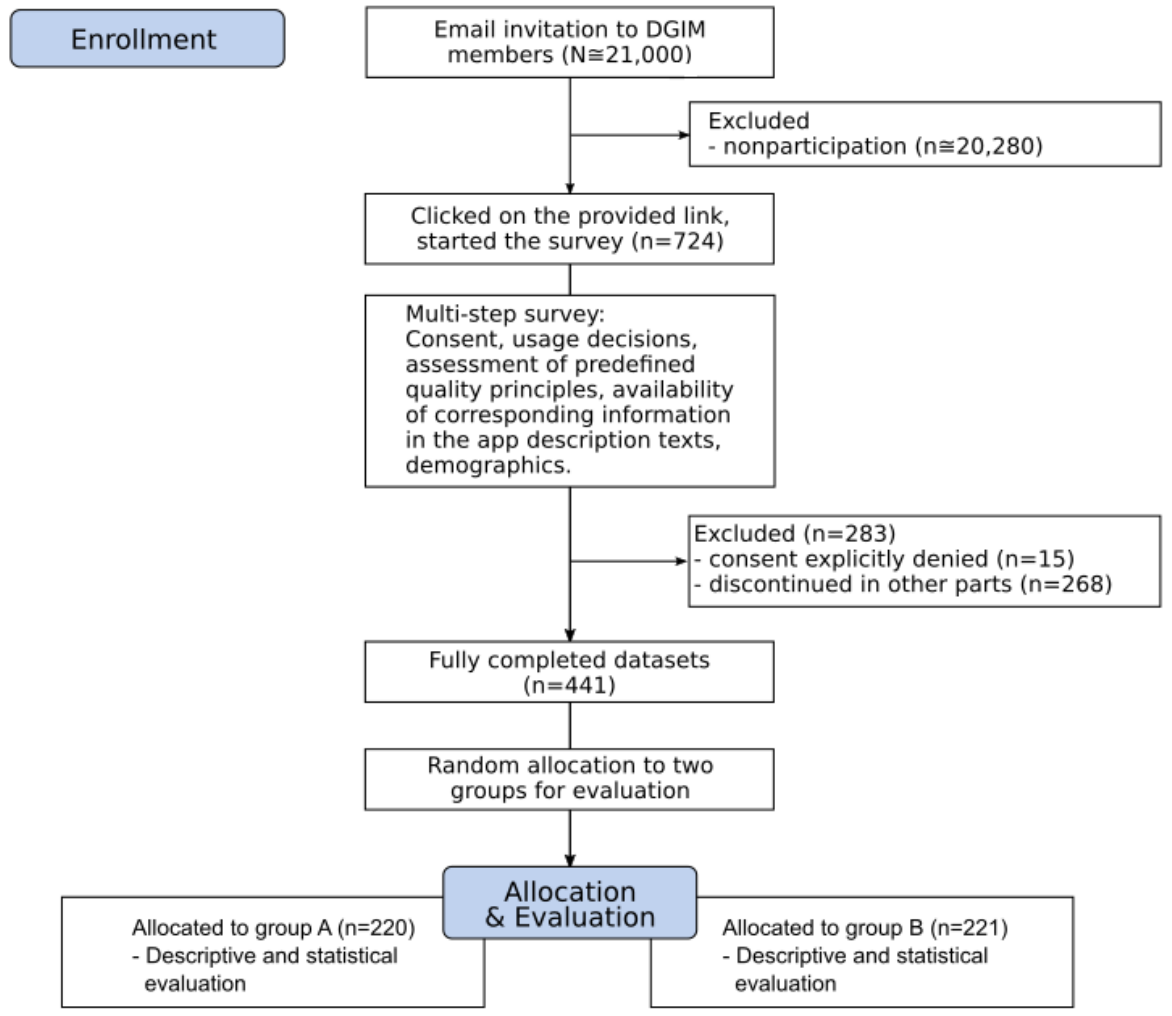
Figure 1. Study flowchart. DGIM: Deutsche Gesellschaft für Innere